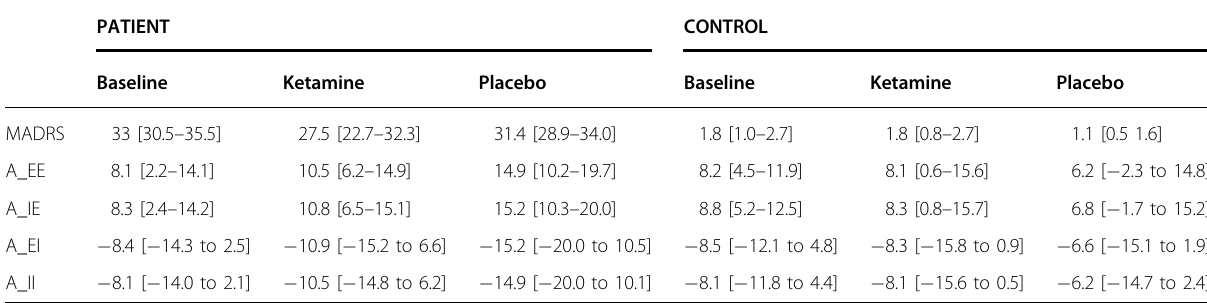
Table 1 Mean and 95% con fi dence intervals for depression severity as measured by the MADRS, and posterior E/I coupling parameters for self-excitatory (A_EE), cross_excitatory (A_IE), cross-inhibitory (A_EI) and self-inhibitory (A_II) parameters obtained from Bayesian model inversion (see Appendix